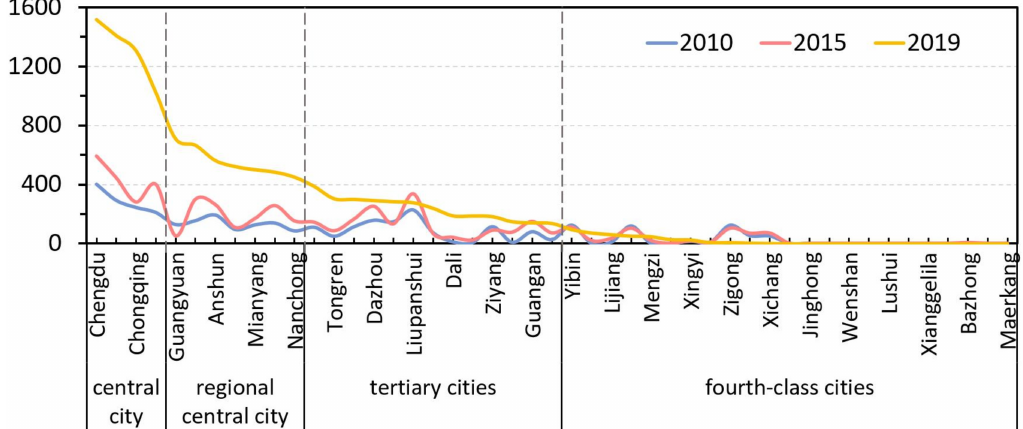
Figure 5. Evolution of urban centrality in southwest China (2010, 2015, 2019).